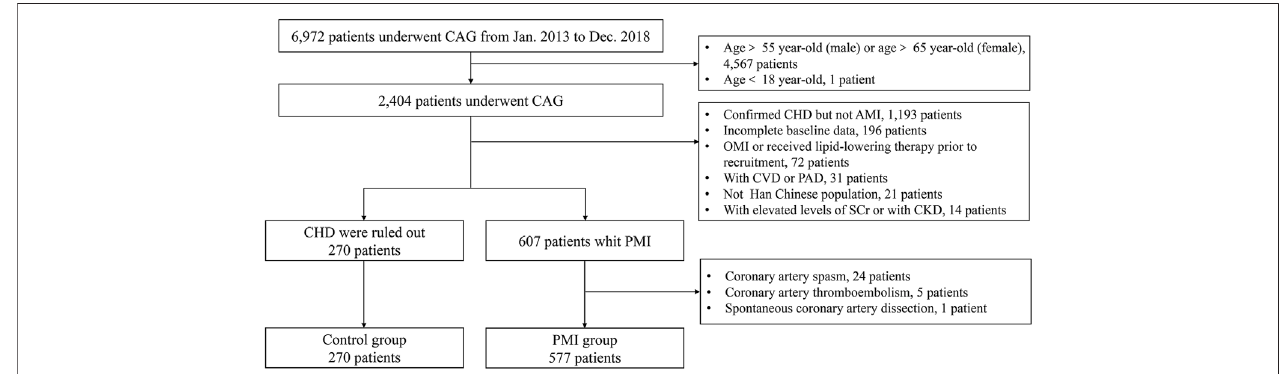
FIGURE 2 | Study fl ow diagram of Cohort 2. CAG, coronary angiography; AMI, acute myocardial infarction, CHD, coronary heart disease, OMI, old myocardial infarction; CVD, cerebrovascular disease; PAD, peripheral arterial disease; SCr, serum creatinine; CKD, chronic kidney disease.